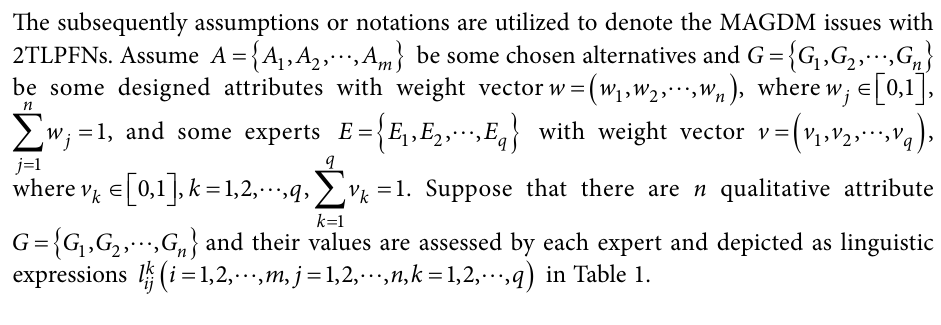
Table 1. Linguistic variables and their 2TLPFNs Linguistic